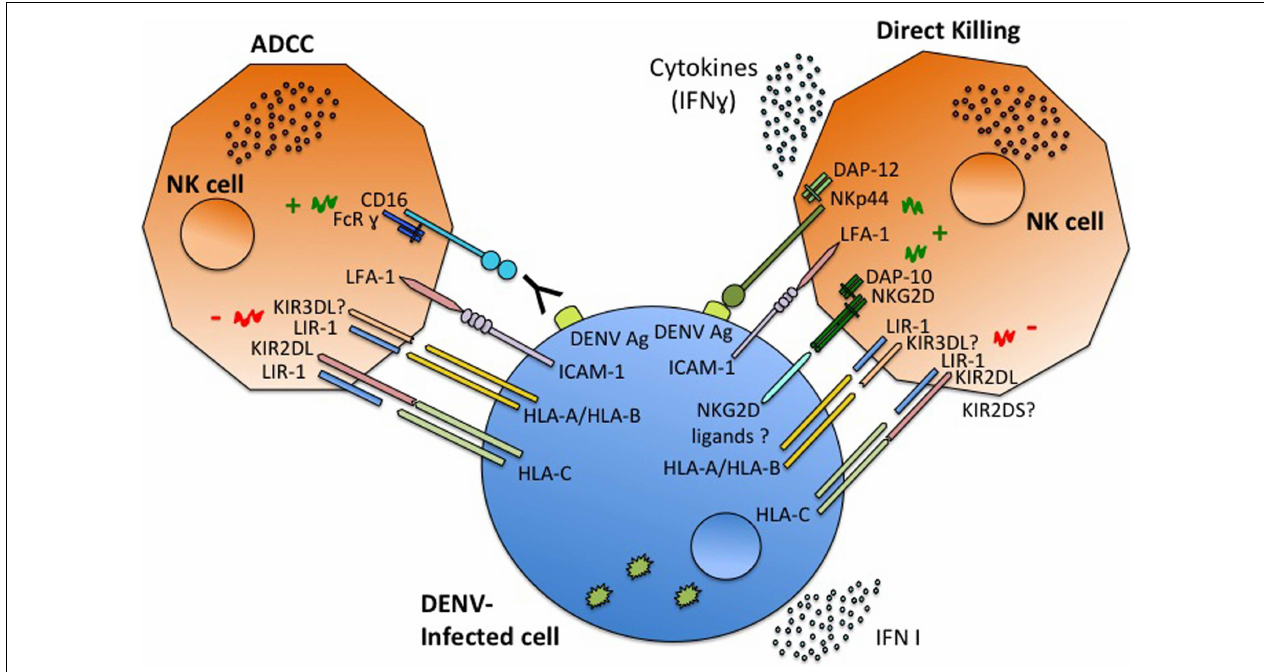
balance between activating or inhibitory signals. Once activated NK cells are capable of ADCC or direct cytotoxicity, and of producing cytokines, mainly IFN γ